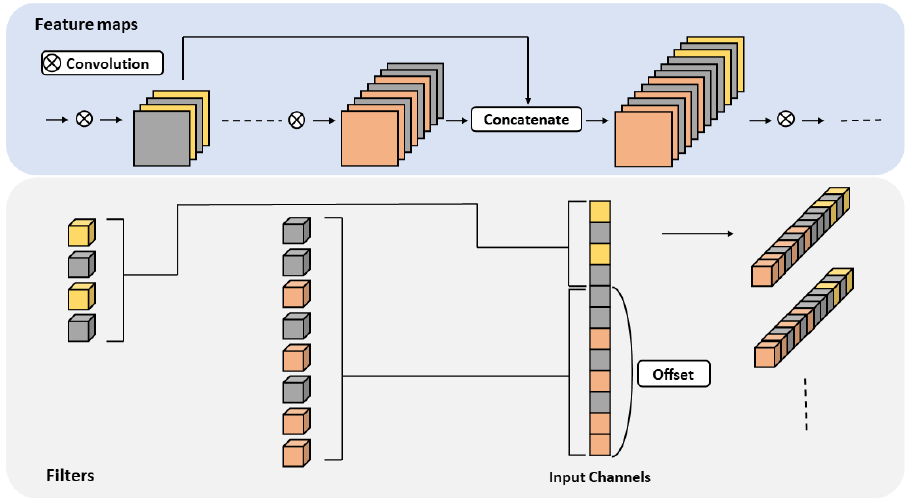
Figure 3. Overview of proposed reconstruction method for the skip connection. Gray indicates a value of zero, while yellow and red represent the remaining filters in the shallower and deeper layers, respectively. Our method offsets the remaining index of a shallow layer as a filter size of a deeper layer during the reconstruction stage. Finally, the gray items are eliminated after